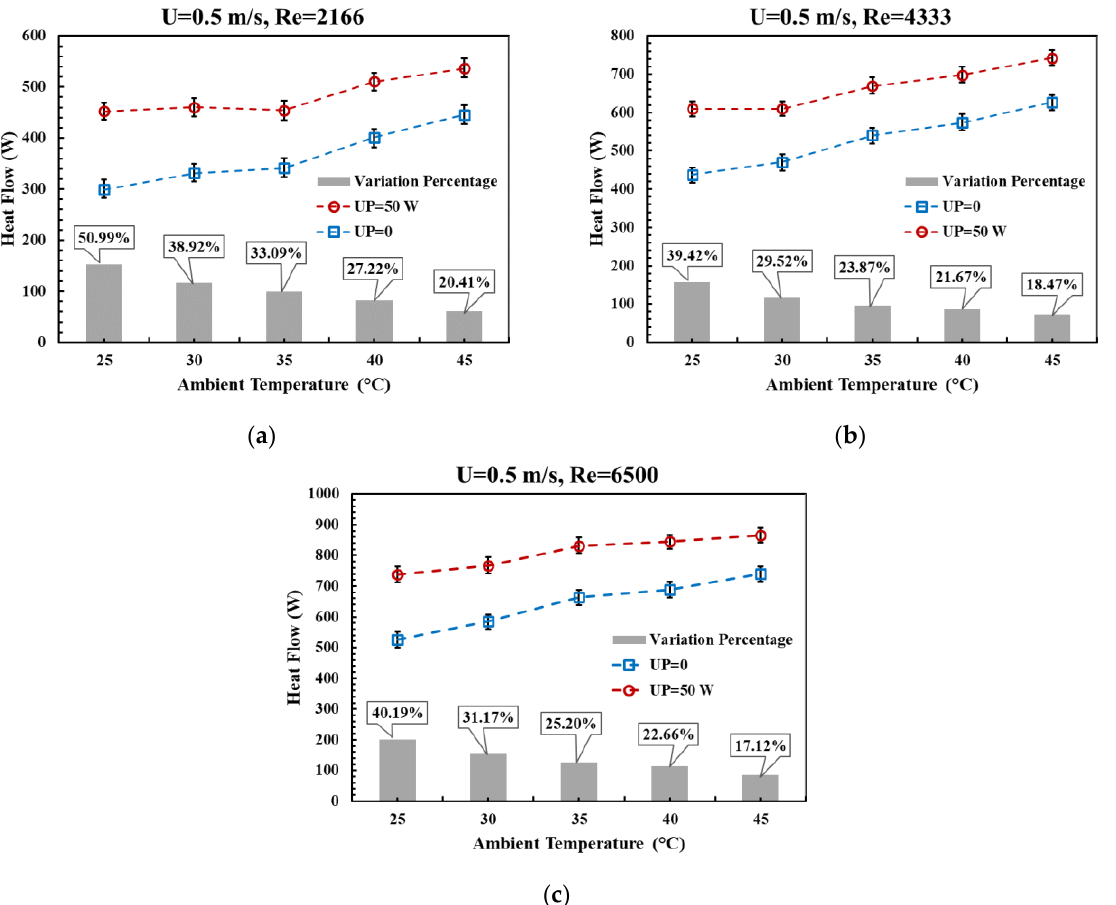
Figure 8. The variations of heat flow against ambient temperature at U = 0.5 ( m/s ) and Reynolds numbers of ( a ) Re = 2166, ( b ) Re = 4333, and ( c ) Re = 6500. The results are presented in a no-vibration state (UP = 0) and in the presence of vibration with ultrasonic power of 50 Watts (UP = 50 (W)).